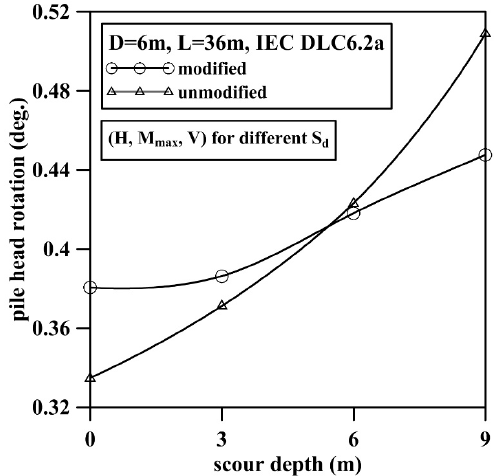
Figure 13. Relationship between the pile head rotation on the surface before scour occurred and scour depth.